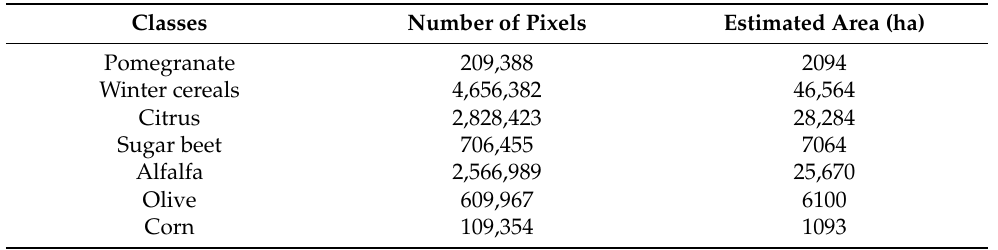
Table 6. The number of pixels and estimated area based on the TIP crop classification result for the season